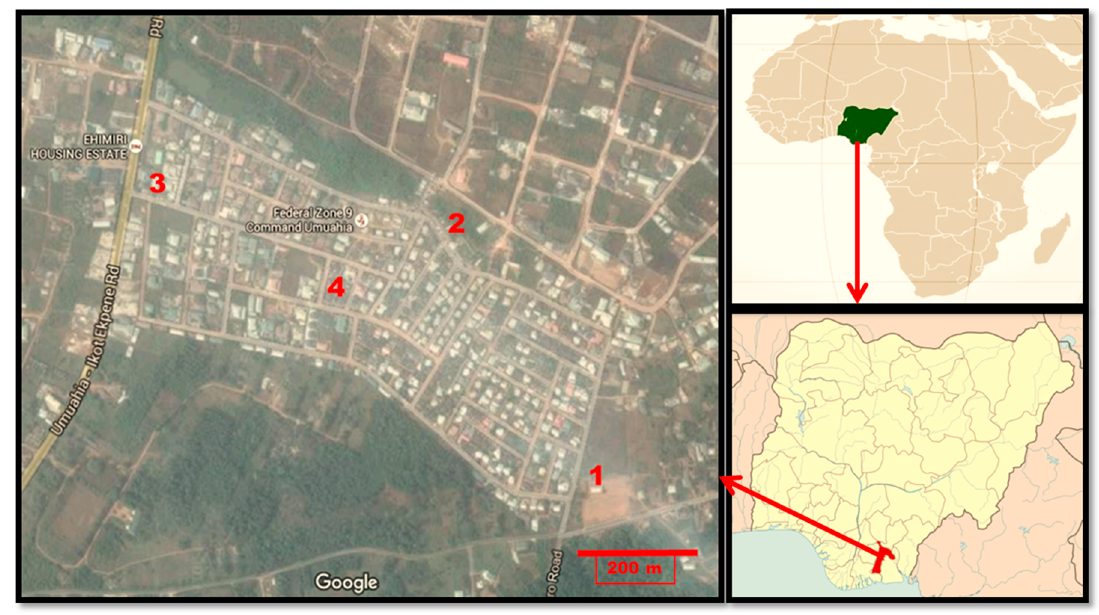
Figure 1. Map of Ehimiri housing estate, Umuahia, indicating the location of the studied Schools 1–4 and location on the maps of Nigeria and Africa. Adapted from Google Map. Scale bar = 200 m.